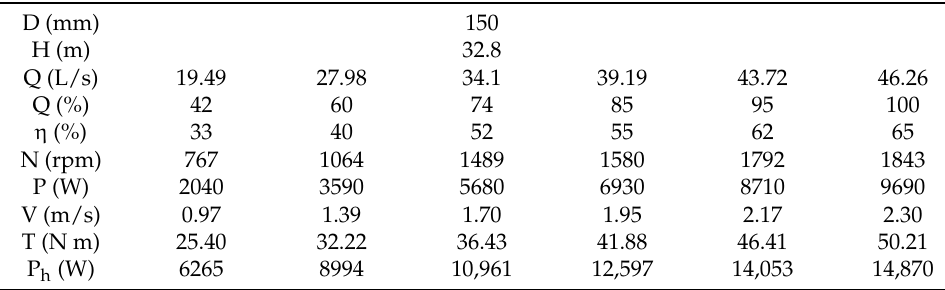
Table 1. Experimental results of the turbine